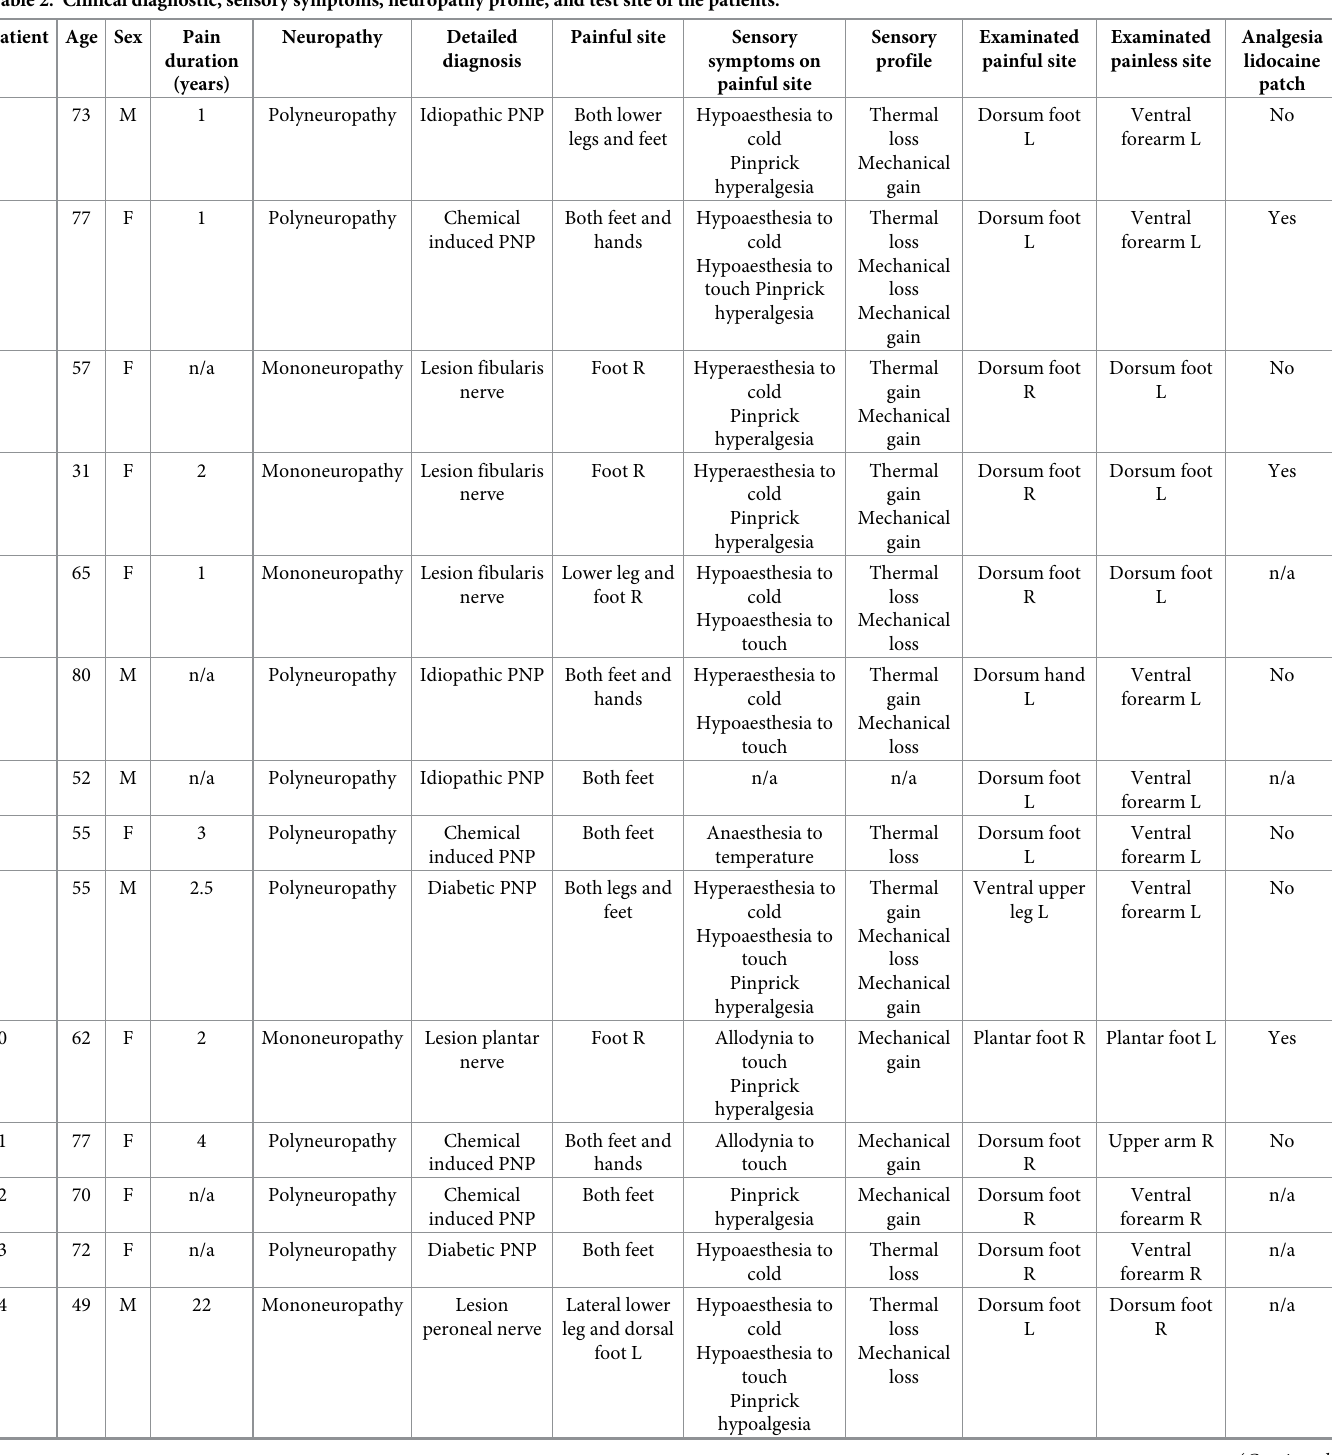
Table 2. Clinical diagnostic, sensory symptoms, neuropathy profile, and test site of the patients. Patient Age